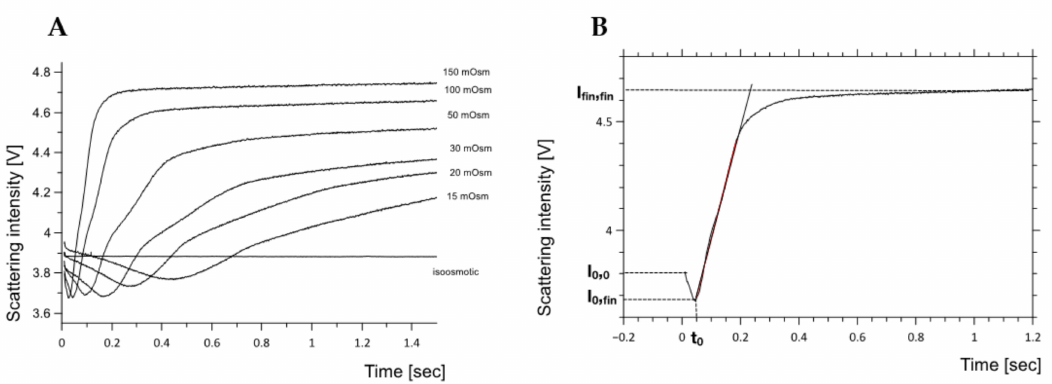
Figure 1. ( A ) Light scattering kinetics of egg-PC liposomes exposed to various osmotic pressure differences, collected shortly after a vesicle suspension had been mixed with KCl solution. The straight horizontal line was obtained at isosmotic condition indicating the intensity level of the scattered light when vesicles are invariant with time. ( B ) The illustration of the vesicle shrinkage kinetics and their division into three stages: the initial decrease of the light scattering intensity (stage I) doe to the outer aqueous phase equilibration, next due to the water outflow (stage II) the inner-vesicle aqueous phase equilibrates (stage III). The parameterization of liposome shrinkage kinetics was achieved by selecting the average slope determined from stage II and t 0 as the time needed to reach minimum of the scattered light intensity (the duration of stage